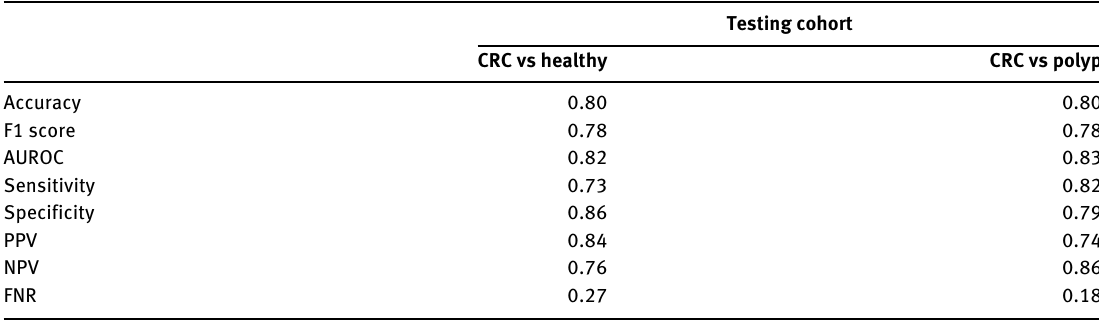
Table 1: Models’ performance measurements for both classification tasks, CRC versus healthy subjects and CRC versus polyp subjects, respectively.